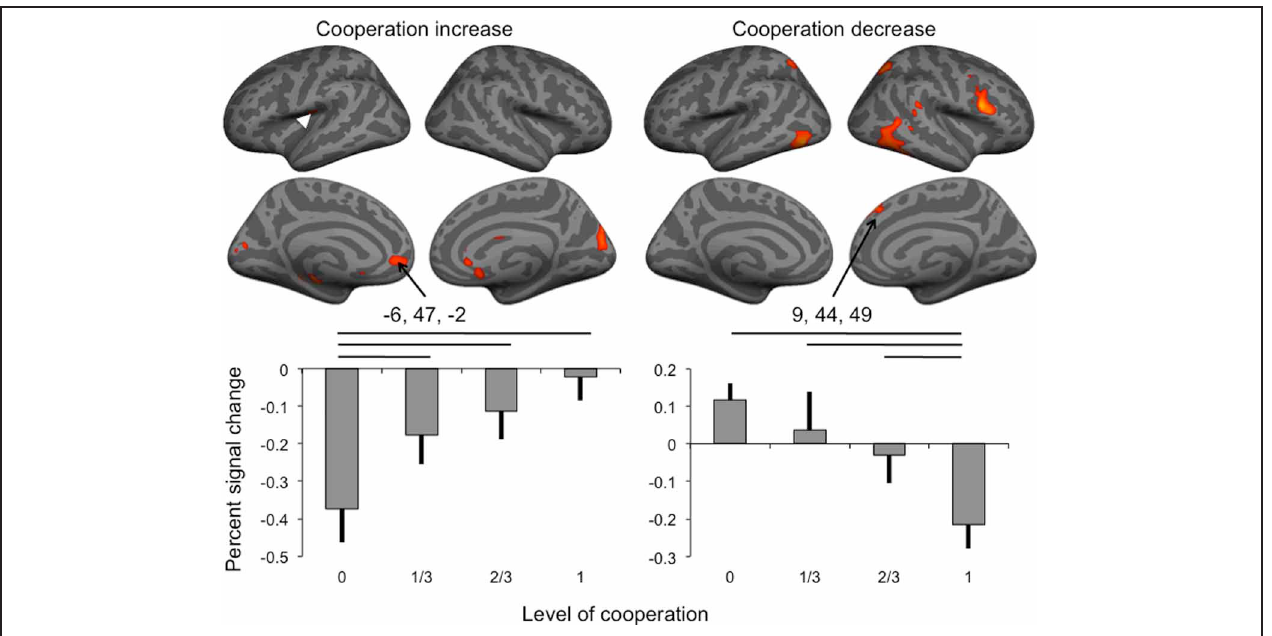
FIGURE 3 | Brain activity associated with the increase and the decrease of the level of cooperation (white arrowhead: location of SII cluster buried in parietal operculum), and percent signal change